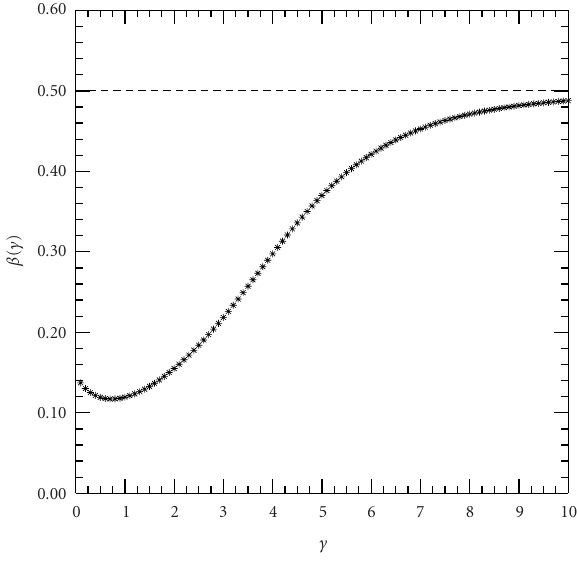
Figure 2.3. Variation of the scaling exponent β as a function of γ in the range 0 . 1 < γ <